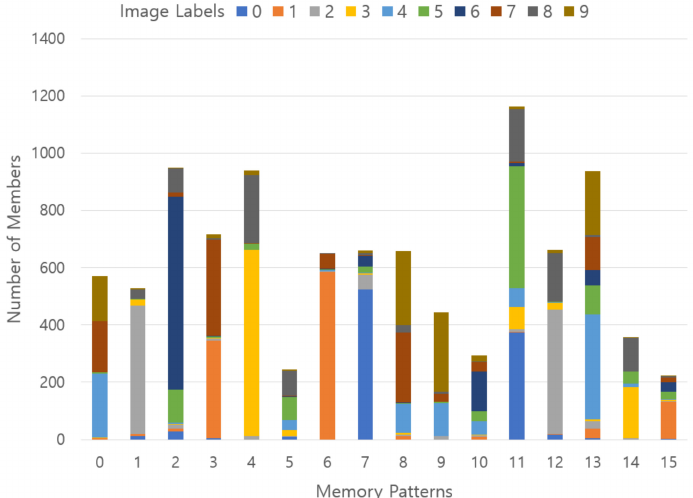
Figure 17. Results of stored memory pattern in an experiment using 20% SDR overlap without the pre-memory process; x -axis represents the memory patterns, y -axis describes the number of members belonging to each memory pattern, and a vertical color code indicates a ground-truth label ratio belonging to each memory pattern.